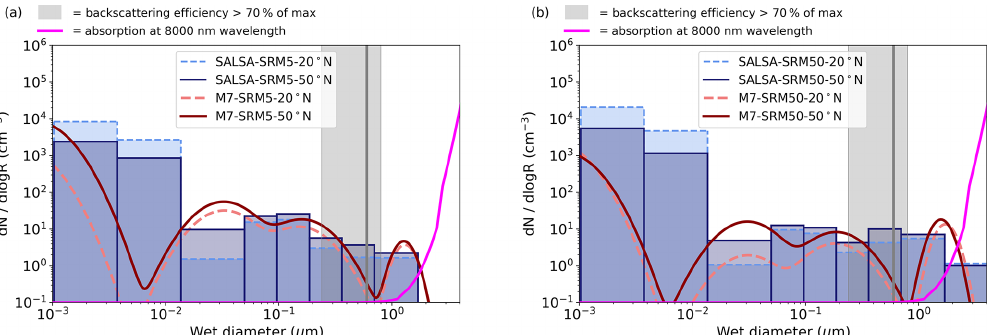
Figure 5. Aerosol number size distribution at 20 ◦ N and 18–20km altitude and at 50 ◦ N and 12–15km altitude in the (a) SRM5 and (b) SRM50 scenarios simulated with M7 and SALSA. The grey line is reproduced from Vattioni et al. (2019) and shows the size of the maximum backscattering, and the shaded area indicates the radius where aerosol backscattering is 70% of the maximum (from Dykema et al., 2016). The magenta line (unitless) shows the relative dependence (using a linear, not logarithmic, scale) of absorption at an 8000nm wavelength on the (dry) diameter of the sulfate aerosols, based on the radiation module of